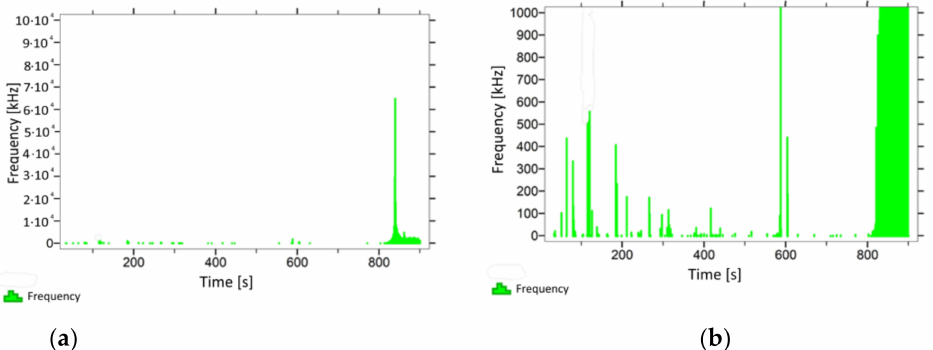
Figure 9. Graph of frequency distribution during the test for a representative sample from series P 8 : ( a ) considering the entire occurring frequency range and ( b ) with details about the frequency range before the moment of breakage.